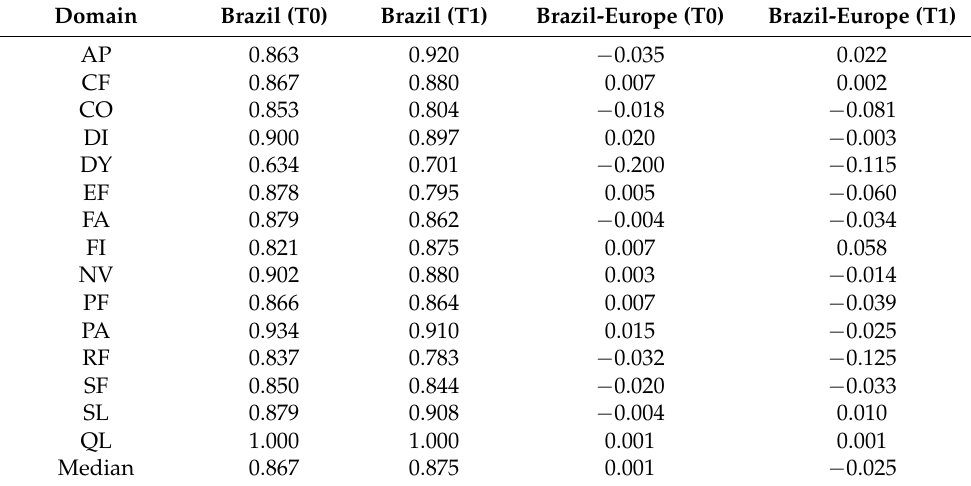
Table 5. Correlations between EORTC CAT Core and QLQ-C30 scores in Brazil and differences in correlations between Brazil and